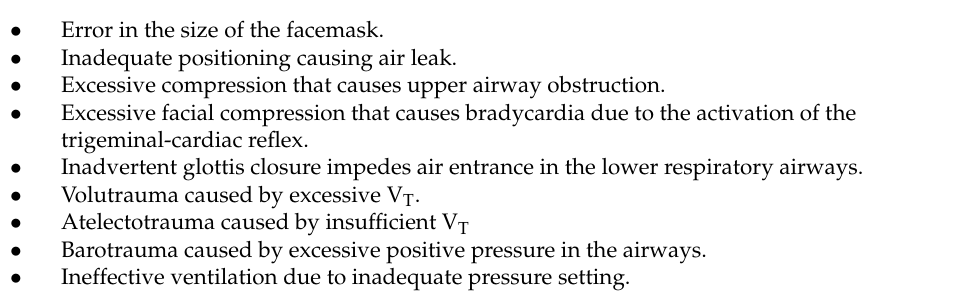
Table 3. Adverse events that reduce the effectiveness of face mask